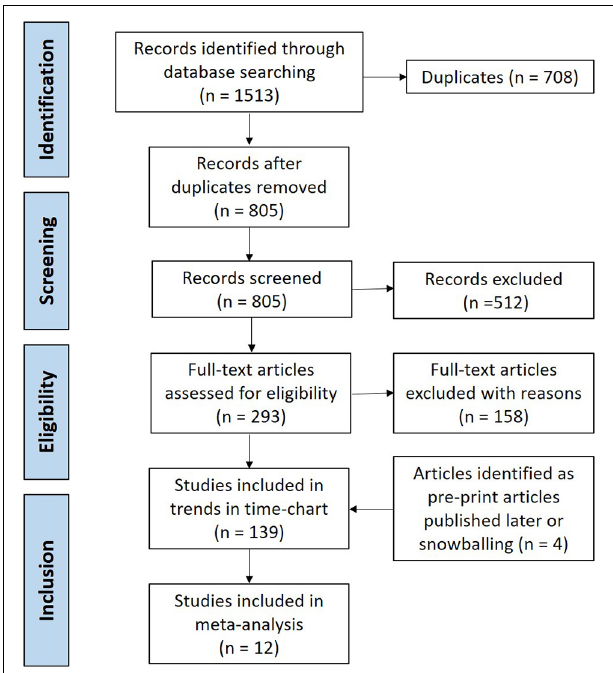
FIGURE 2 | Preferred reporting items for systematic reviews and meta-analysis (PRISMA) chart displaying flow-chart of study screening and